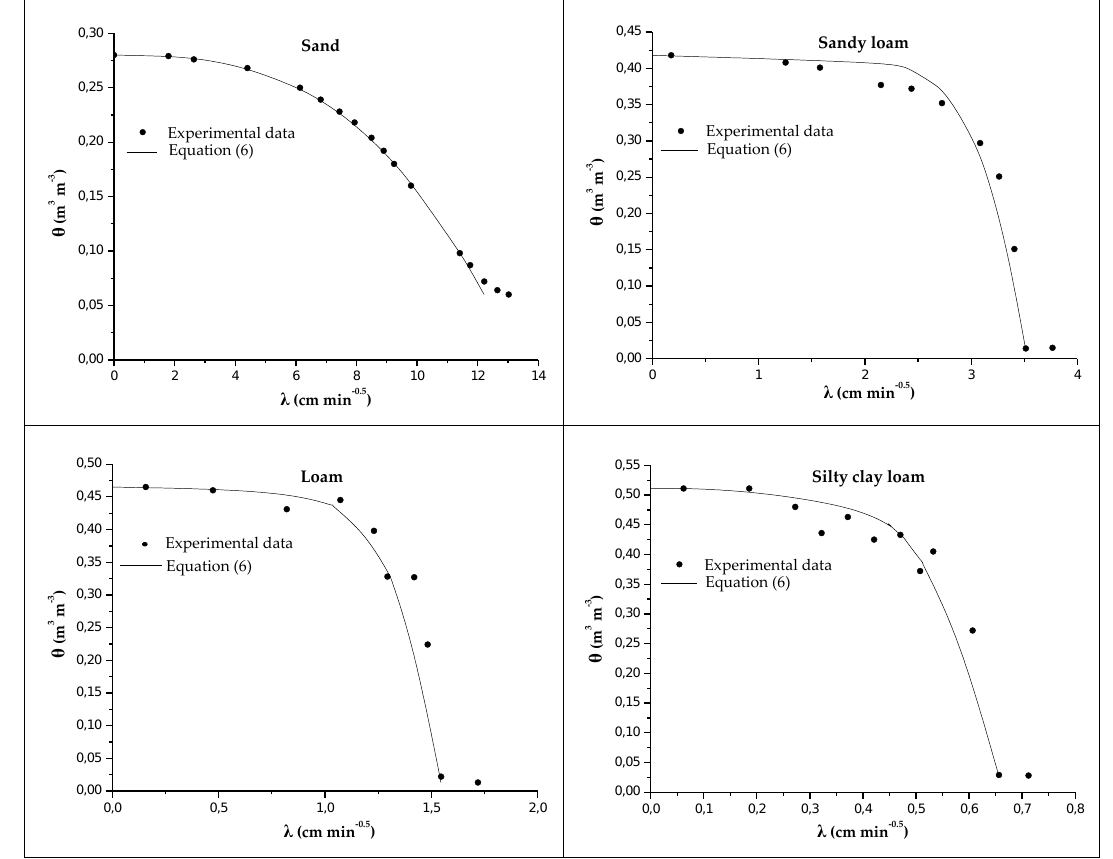
Figure 1. The λ ( θ ) relationships, as obtained directly from experimental θ ( x , t ) data for each soil, and the estimated values according to Equation (6).